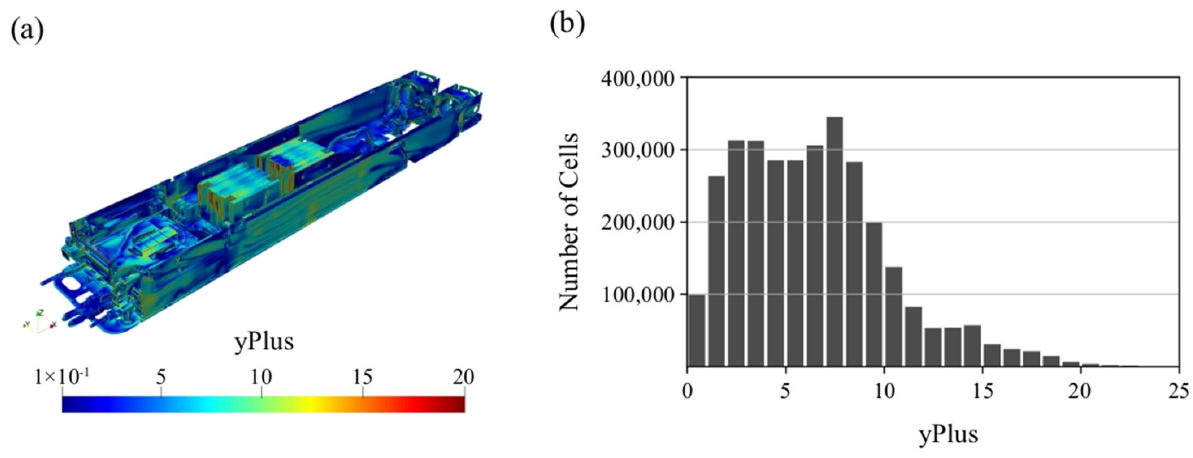
Figure 8. ( a ) Distribution of the y + over the server and ( b ) histogram plot of the y + in the computa- tional